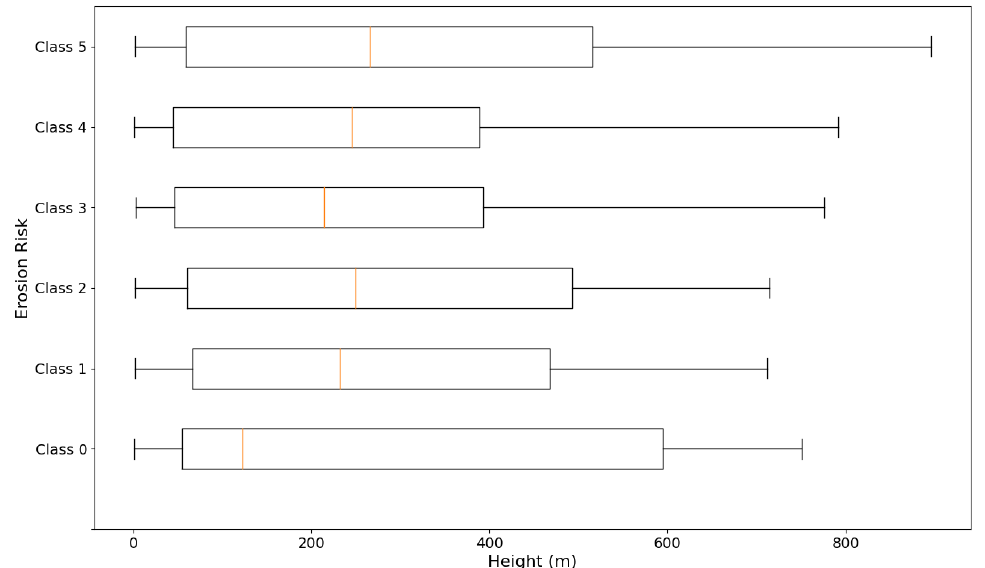
Figure 5. The height distribution across all regions in the training dataset, separated by soil erosion risk